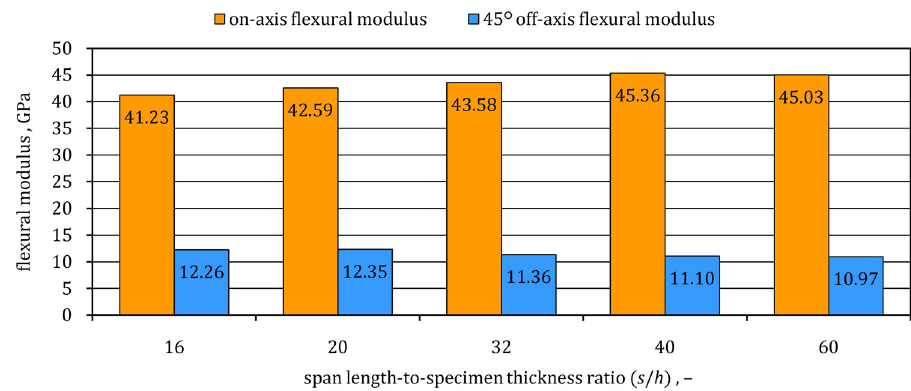
Figure 8: Comparison of the fl exural modulus of the on - axis and 45° o ff - axis specimens at various values of ( s / h )